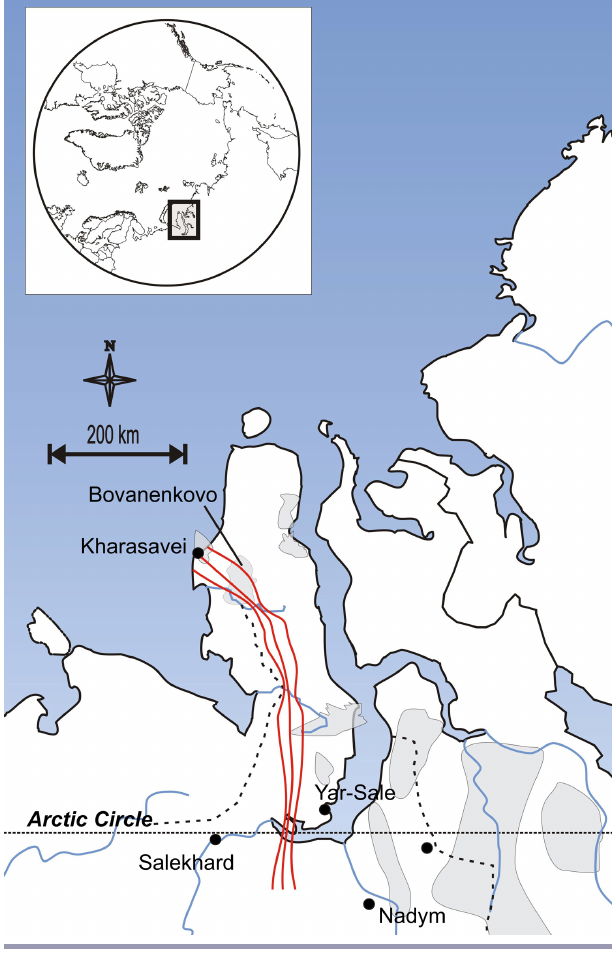
Fig. 4 . Examples of modern nomadic routes (solid red lines) on Yamal Peninsula in relation to the gas fields at Bovanenkovo and Kharasavei port and the Obskaya- Bovanenkovo railway (dashed black line).